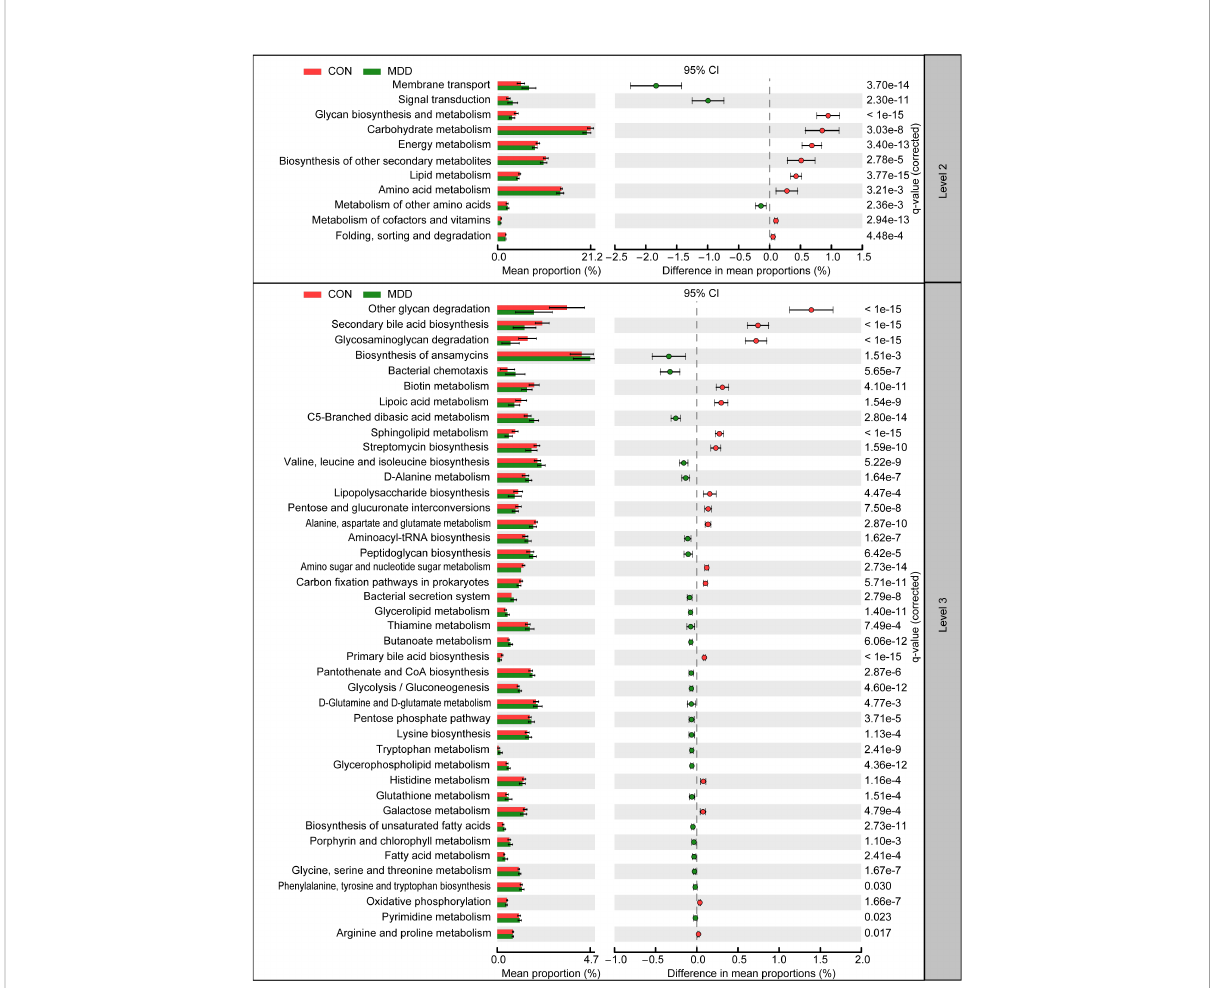
FIGURE 6 PiCRUSt-basedexaminationof thefecal microbiotaof childhoodMDDpatients andthehealthycontrols. Thedifferentbacterial functionswereevaluated betweenthembasedontwo-sidedWelch ’ s t -test. Comparisonsbetweenthegroupsforeach KEGGfunctional category(levels 2and3)are shownby percentage. TheBenjamini – Hochbergmethodwasusedformultipletestingcorrection basedonthe falsediscovery rate(FDR)through